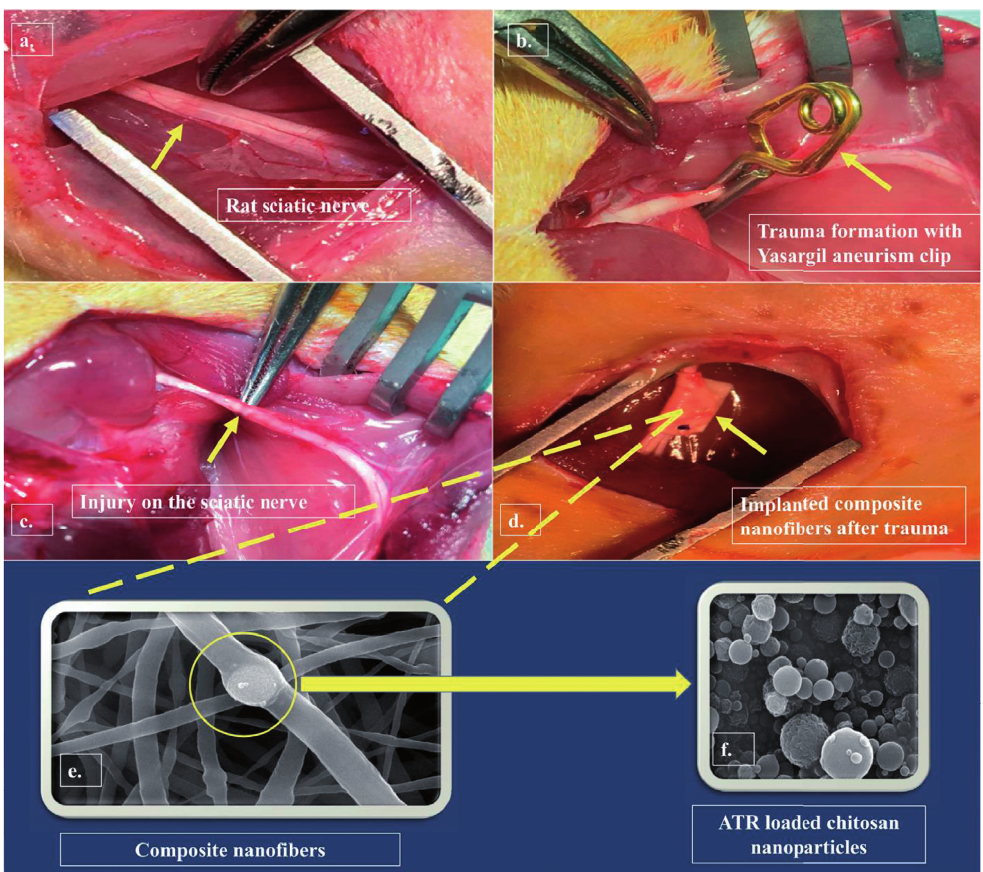
Figure 5: In vivo animal model for peripheral nerve injury on the sciatic nerve (a). A healthy sciatic nerve after surgical splitting of the muscles (b). Application of the Yasargil aneurism clip for trauma on the sciatic nerve (c). The sciatic nerve injury site after removal of the Yasargil aneurism clip (d). Implantation of composite nanofibers around the injured sciatic nerve just after the trauma (e). Scanning electron microscopy images of (e). Composite nanofibers containing ALA- and ATR-loaded chitosan nanoparticles (f). ATR-loaded chitosan nanoparticles existing in the composite nanofiber structure; reproduced with permission from